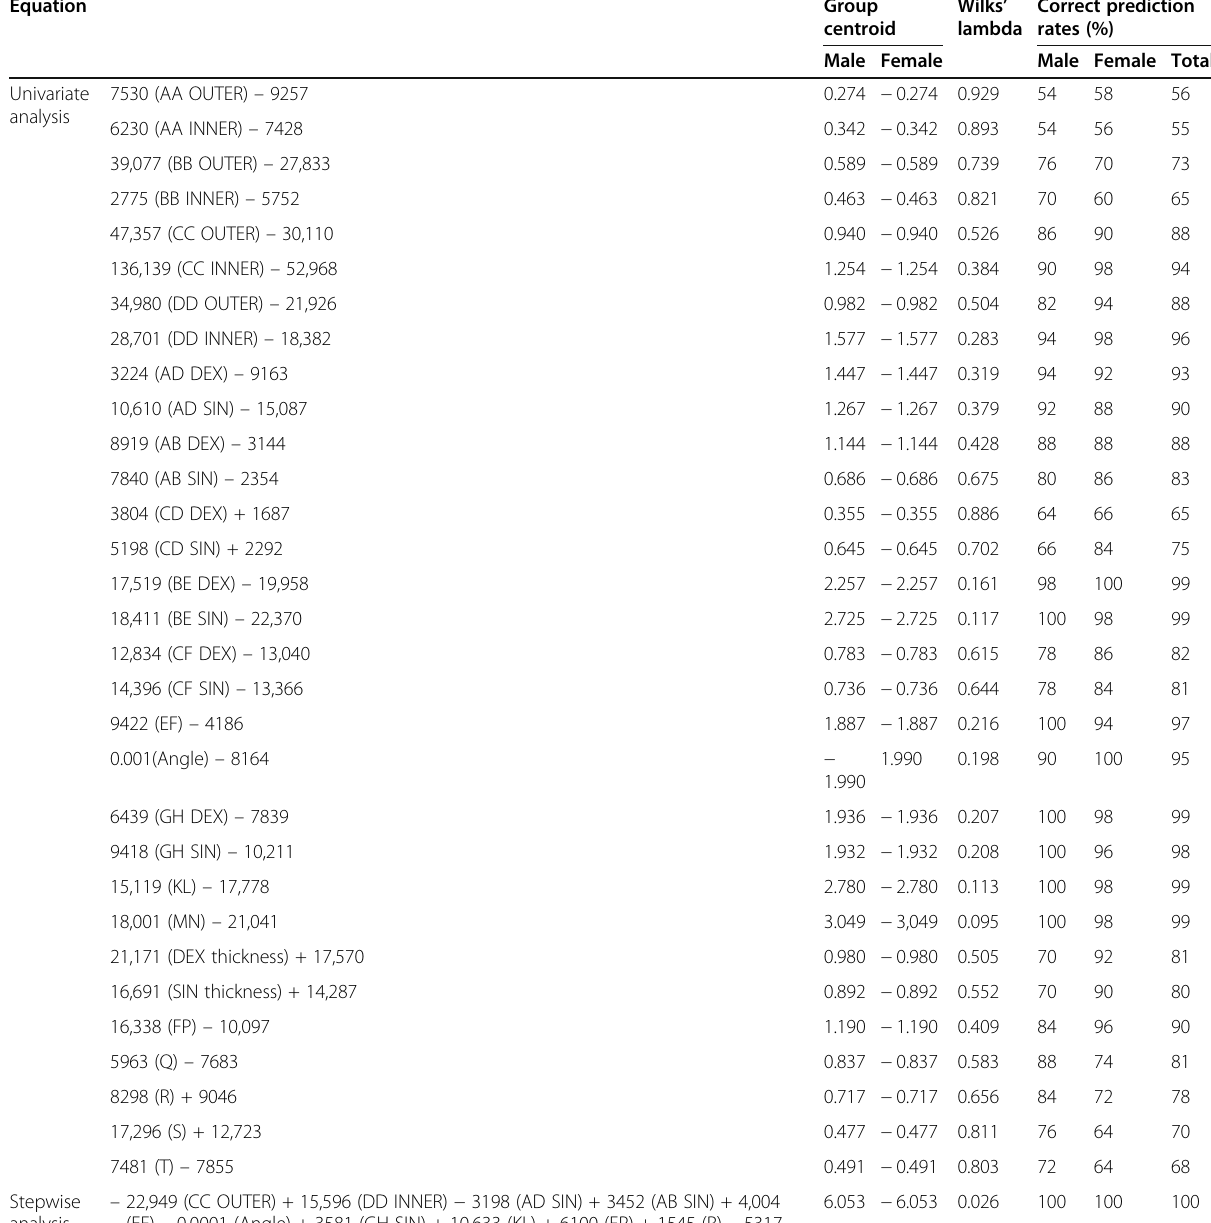
Wilks ’ Correct prediction centroid lambda rates (%) Male Female Male Female Total